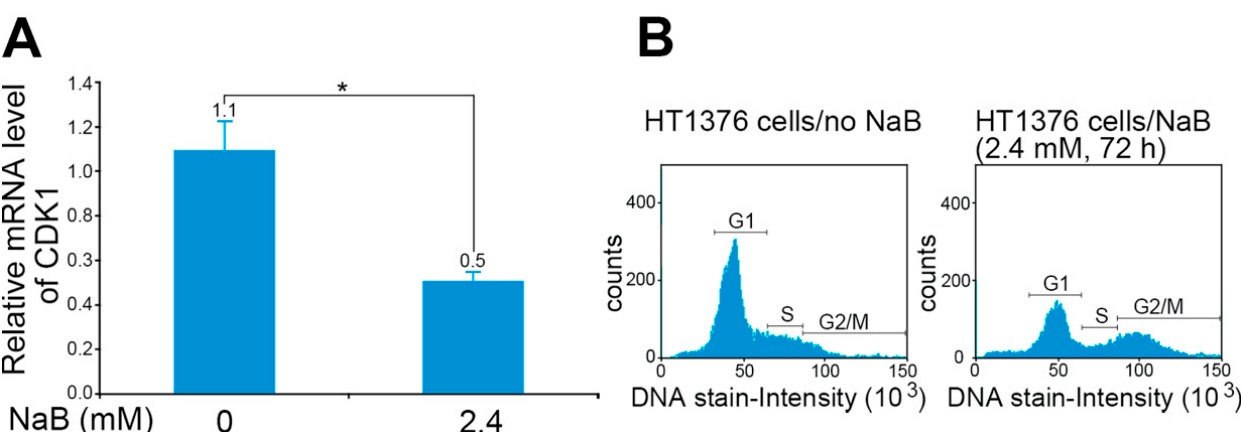
Figure 4. Regulation of cell cycles in bladder urothelial cancer cells by NaB. ( A ) Relative mRNA level of CDK1 in HT1376 cells. ( B ) Cell cycle distribution of HT1376 cells after NaB treatment. Data are the mean ± SEM of at least two independent experiments. NaB, sodium butyrate. * p < 0.05.